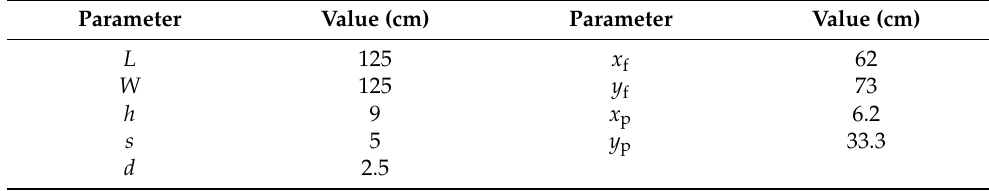
Figure 5. Geometry of the proposed QMSIW antenna: ( a ) a bird’s-eye view, ( b ) a top view. Table 1. QMSIW antenna parameters.